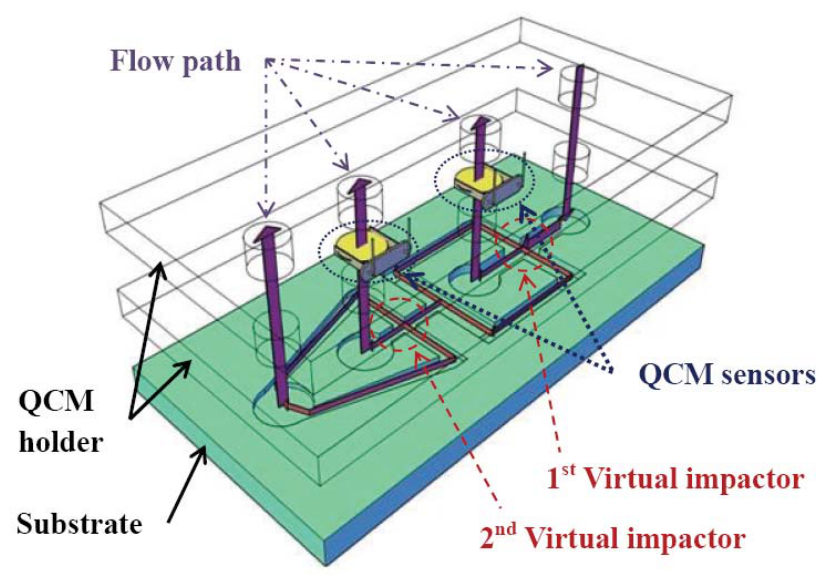
Figure 1. Schematic of virtual impactors integrated with QCM sensors for detecting aerosol particles. The QCM sensors are fixed by the QCM holders. The virtual impactors with channel substructure will separate particles into three different groups of different